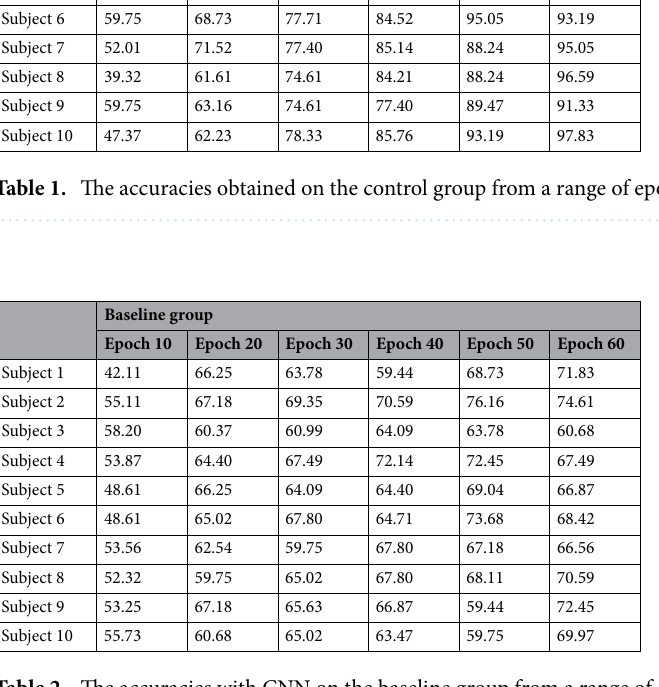
Table 2. The accuracies with CNN on the baseline group from a range of epochs up to 60 (with an increment of 10).